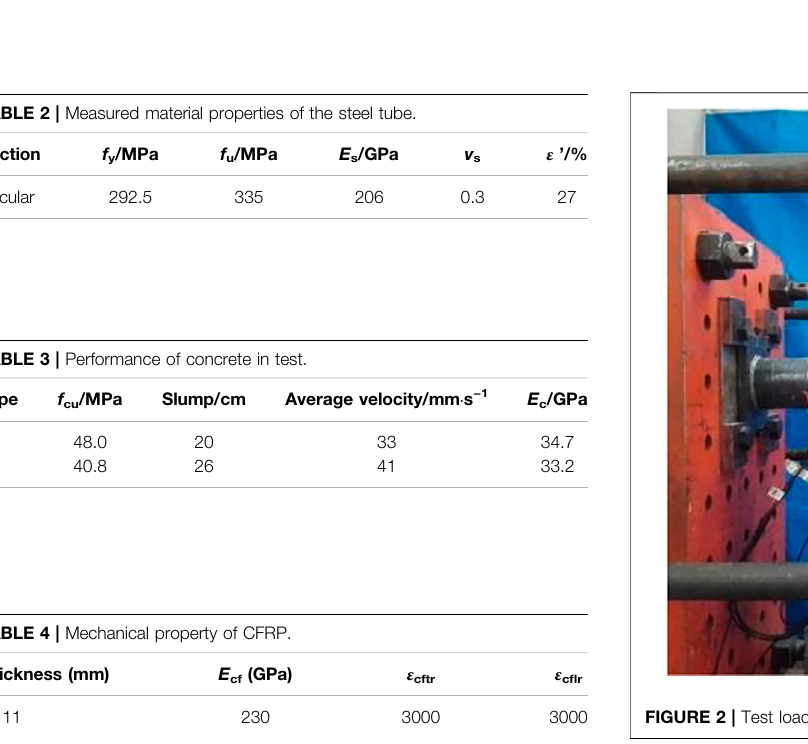
FIGURE 1 | Schematic diagram of the C-CF-CFRP-ST specimen.